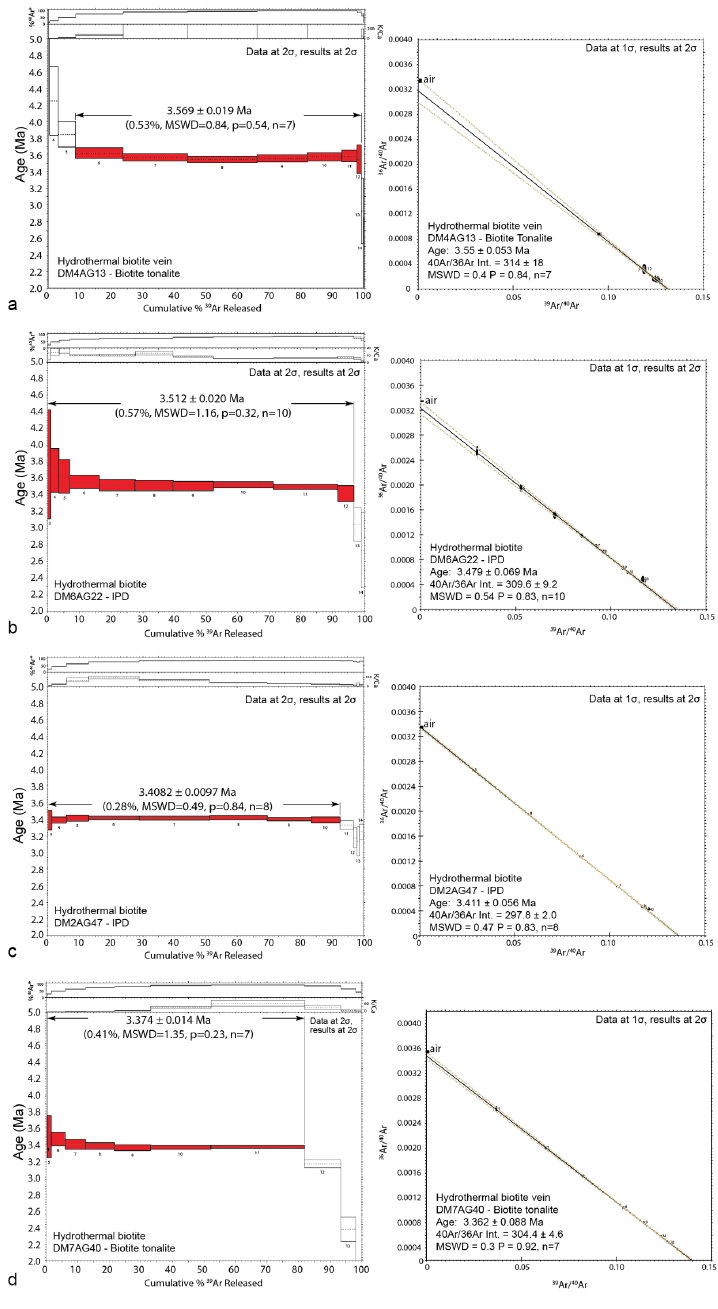
Figure 8. Hydrothermal biotite 40 Ar/ 39 Ar plateau (shown in red) and inverse isochron ages for ( a ) Sample DM6AG22. ( b ) Sample DM2AG47. ( c ) Sample DM4AG13. ( d ) Sample DM7AG40. All uncertainties are shown at the 2σ confidence level.